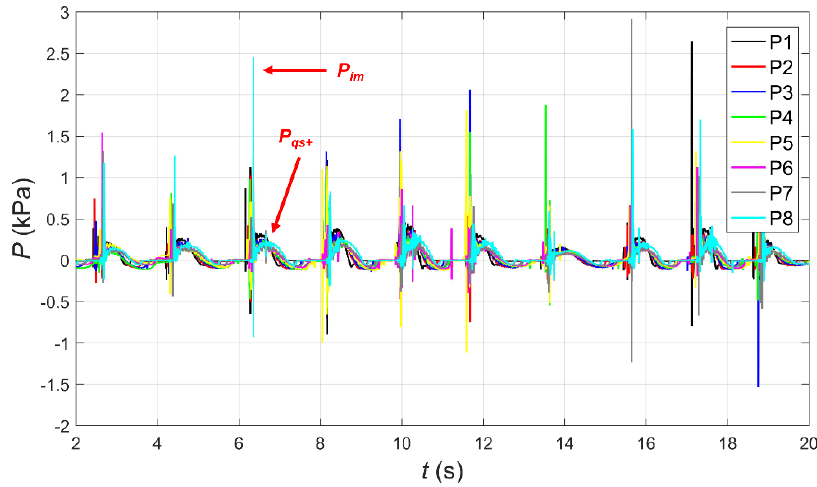
Figure 3. Example time series of wave pressures recorded on horizontal plate for trial T12. Table 3. Classification of wave impact types. P im /P